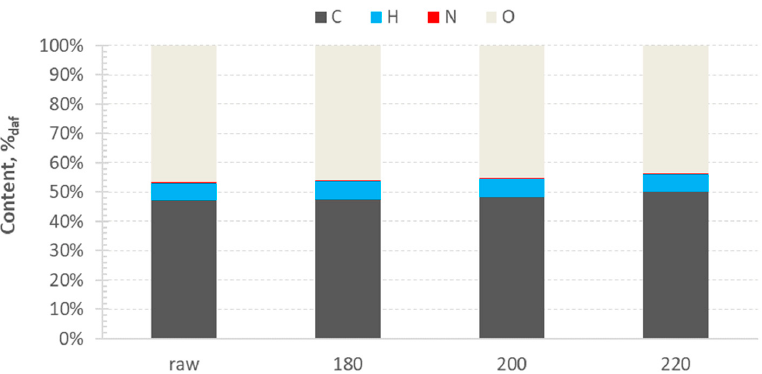
Figure 8. Ultimate analysis of the raw sample, before HTC, and hydrochars obtained at respective temperatures.